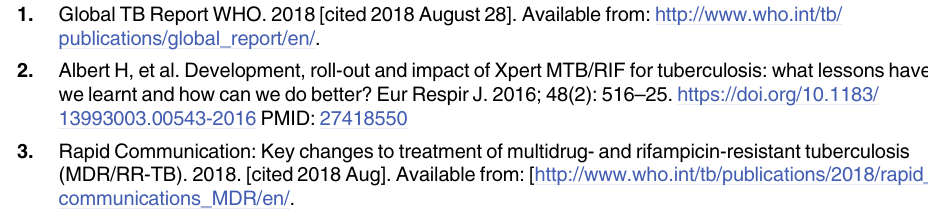
S1 Table. Proportion of confirmed doses, WOT versus DOT, with all weekend days and public holidays excluded in DOT arm, and days with “held” doses excluded in both arms. Confirmed dose defined as 1 or more tablets detected or witnessed. DOT, directly observed therapy; WOT, wirelessly observed therapy. S1 Text. Research protocol. WOT in comparison to DOT for the treatment of TB.